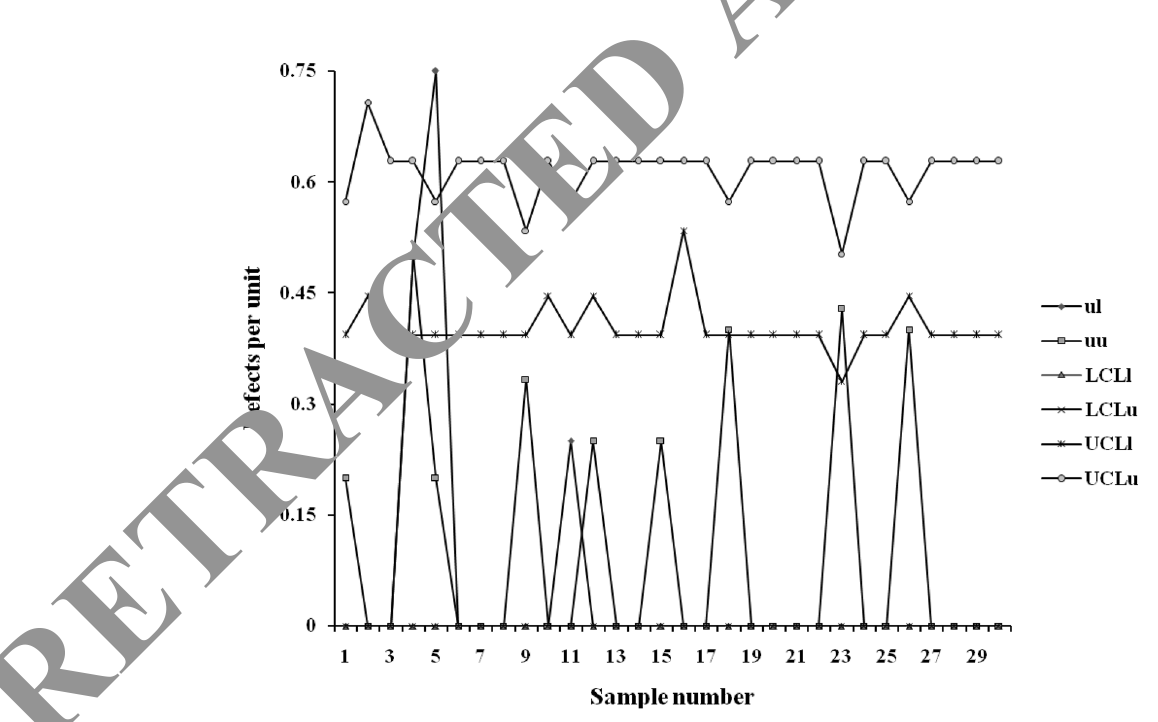
Figure 1. p control chart.